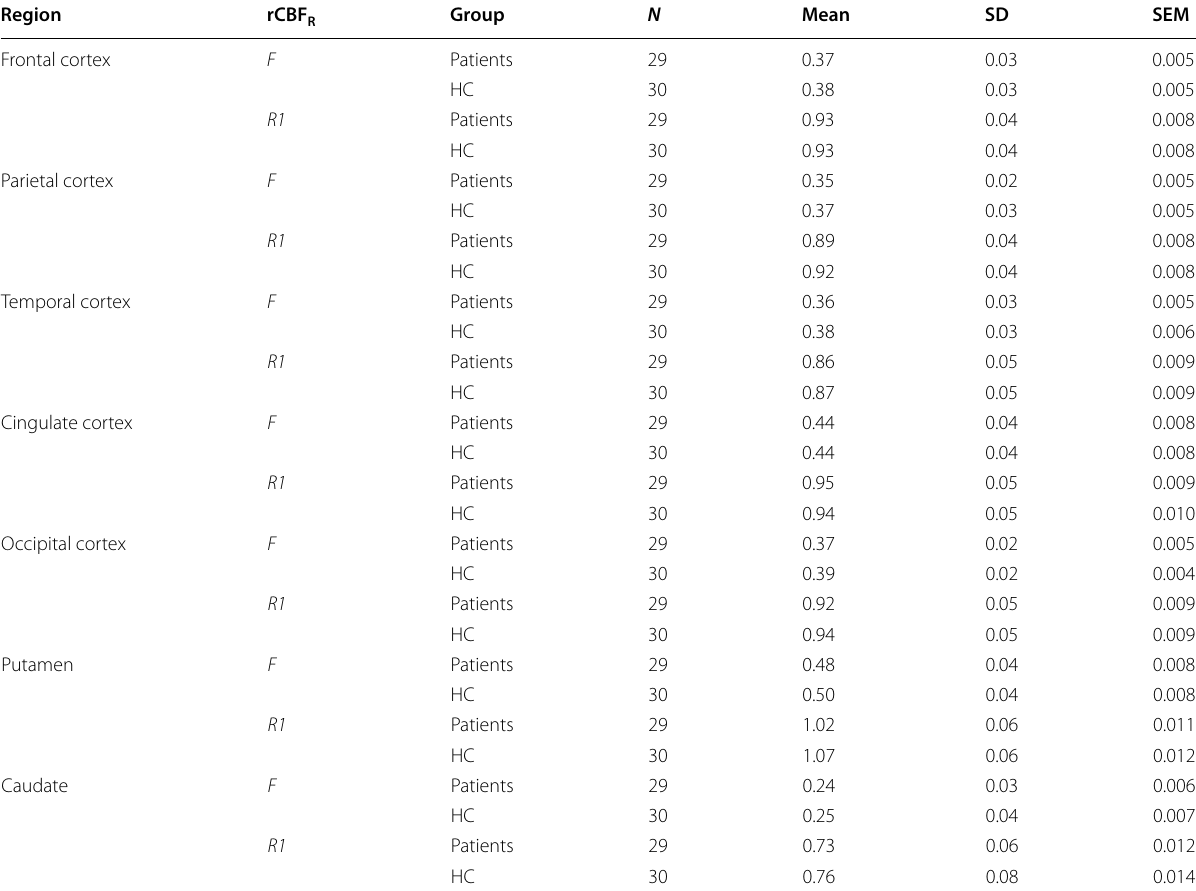
Table 2 rCBF measured with F and R1 in patients and healthy controls R